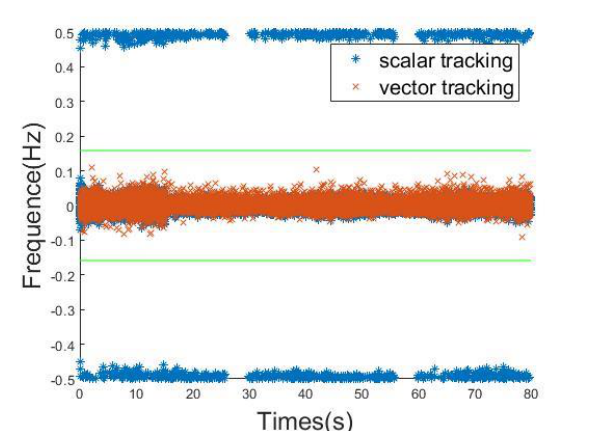
Figure 5. Comparison of VTL and STL frequency tracking error for L1 satellite